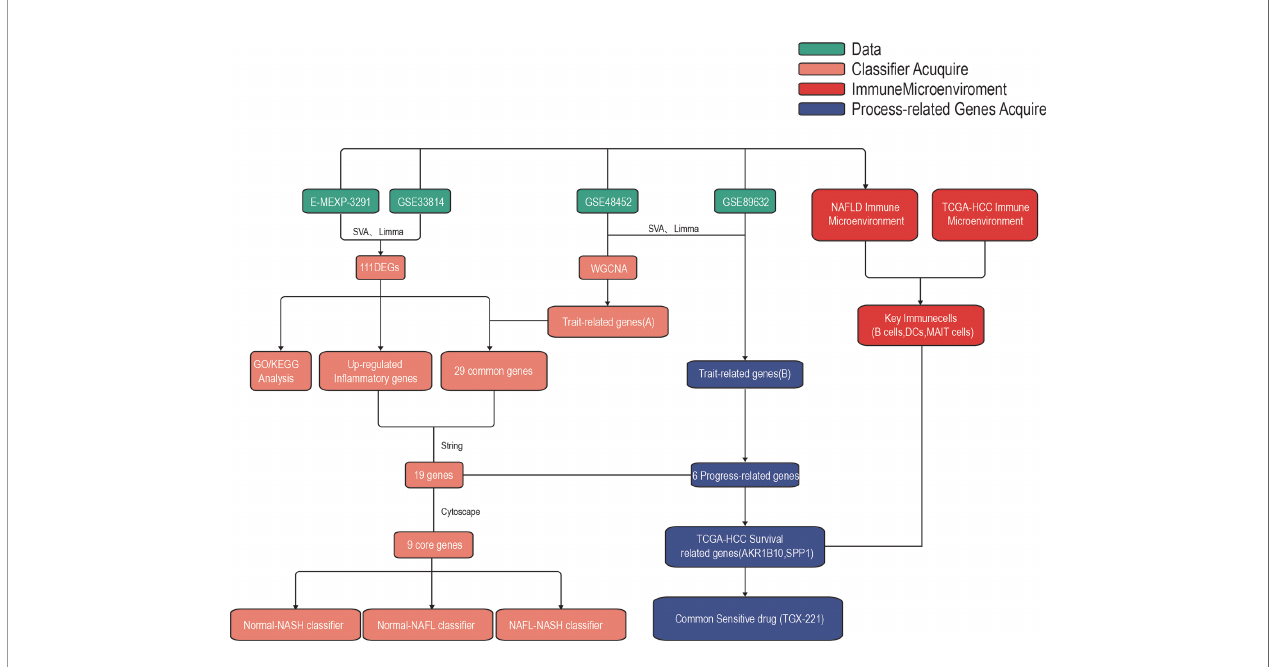
FIGURE 1 | The work fl ow of the present